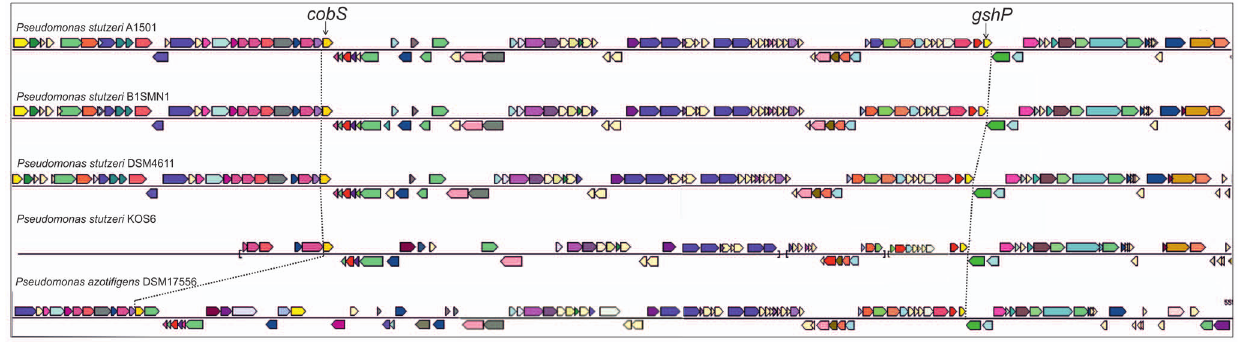
Figure 1. Schematic representation and comparison of the Nitrogen Fixation Islands and flanking genes of diazotrophic P.stutzeri strains A1501, DSM4166, B1SMN1, KOS6 and P.azotifigens DSM 17556. The nitrogen fixation island of P. stutzeri KOS6 was assembled downloading from the Integrated Microbial Genomes (IMG) (https://img.jgi.doe.gov/cgi-bin/w/main.cgi) three contigs (AMCZ01000041, AMCZ01000045 and AMCZ000005) indicated by brackets. The nitrogen fixation island of P. stutzeri strains B1SMN1 and P. azotifigens DSM 17556 were found in one contig. The colored of arrows are indicating different functional genes as described by IMG.